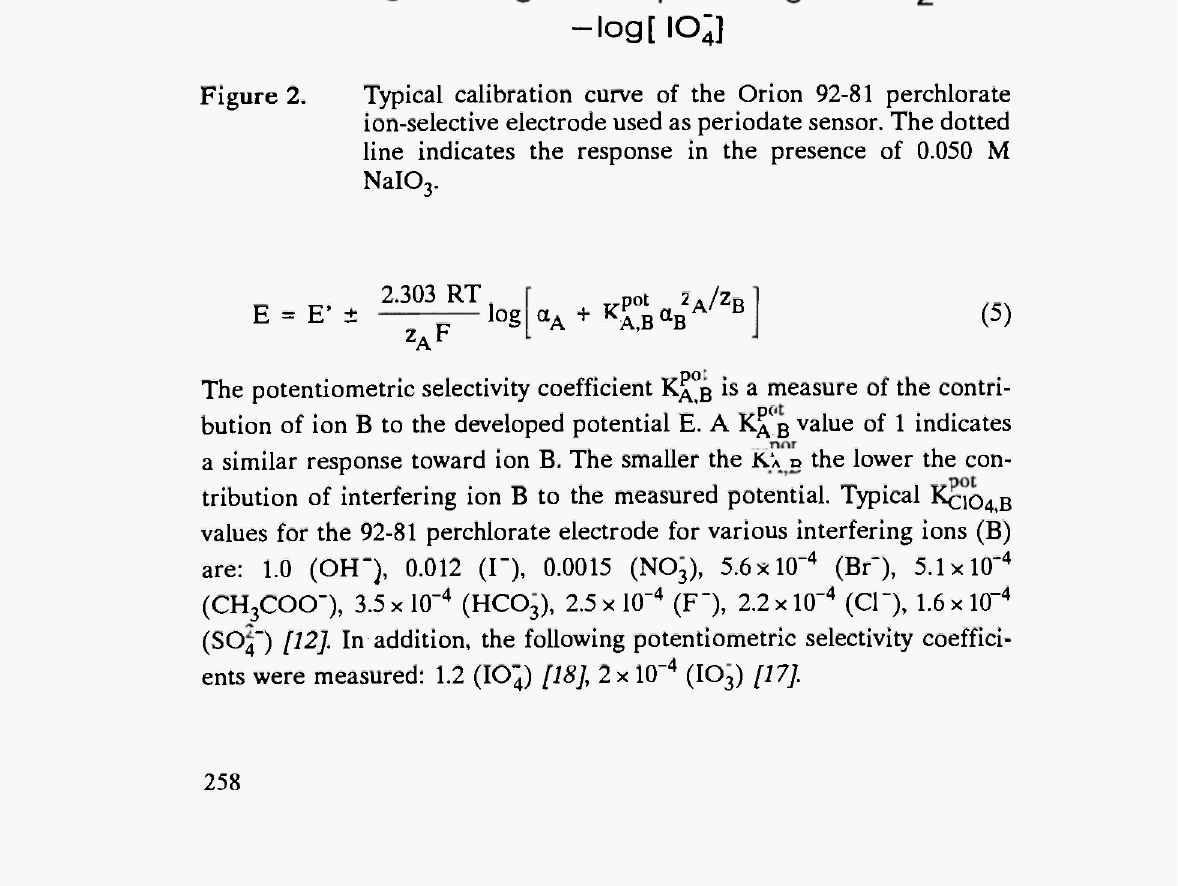
Figure 2. Typical calibration curve of the Orion 92-81 Perchlorate ion-selective electrode used as periodate sensor. The dotted line indicates the response in the presence of 0.050 Μ NaI0 3